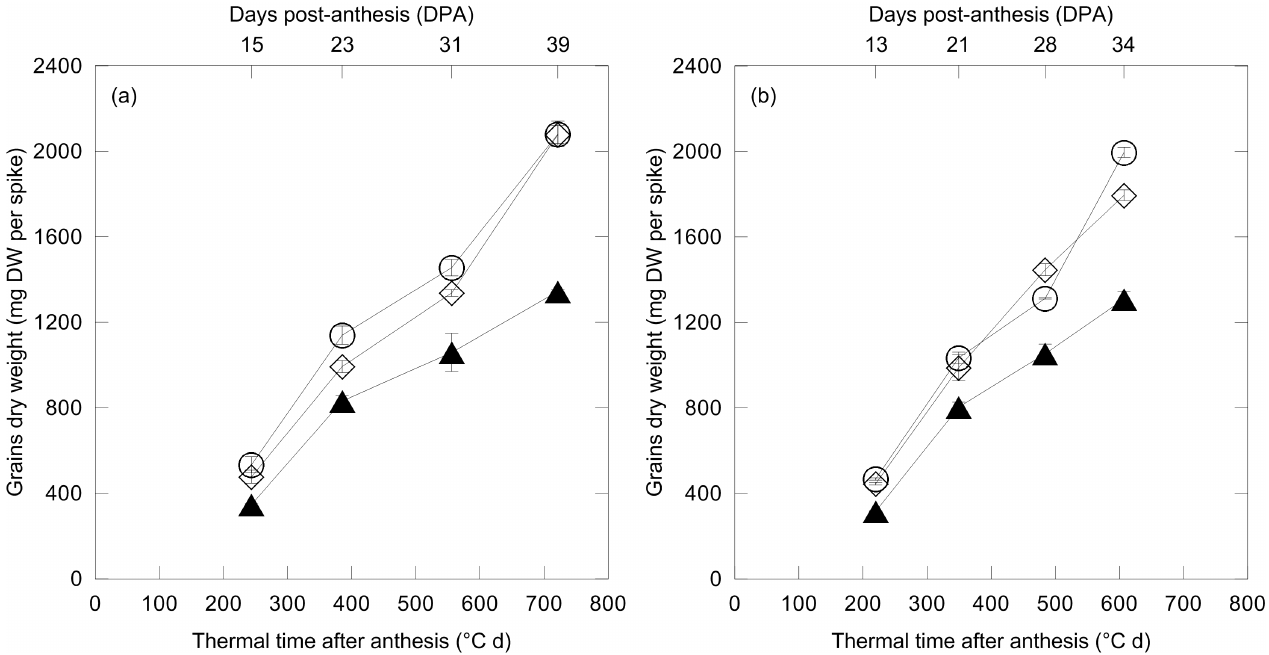
Fig 1. Changes of grain dry weight (mg DW per spike) against thermal time after anthesis (cumulative average daily air temperature exceeding 0°C, °C d) and days post-anthesis (DPA) (above axis) of durum wheat in 2011 (a) and 2012 (b). Wheat plants were exposed to control conditions (unfertilized CONTROL, black triangle) and to two N fertilization treatments with urea (UREA, white rhombus) and calcium nitrate (NITRATE, white circle) at the rate of 150 kg N ha -1 (mean value ± standard errors, n = 3 independent replicates; split-plot ANOVA over thermal time after anthesis; effects: (a) treatment , P < 0.01; time , P < 0.01; treatment x time , P < 0.01; (b) treatment , P < 0.01; time , P < 0.01; treatment x time , P <